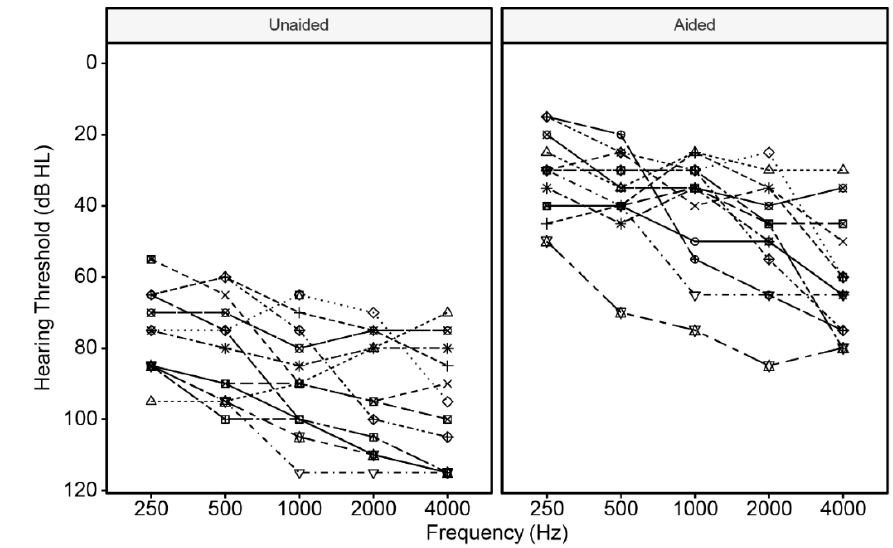
Figure 1. Unaided and aided hearing thresholds for the non-implanted ear of each child participant.